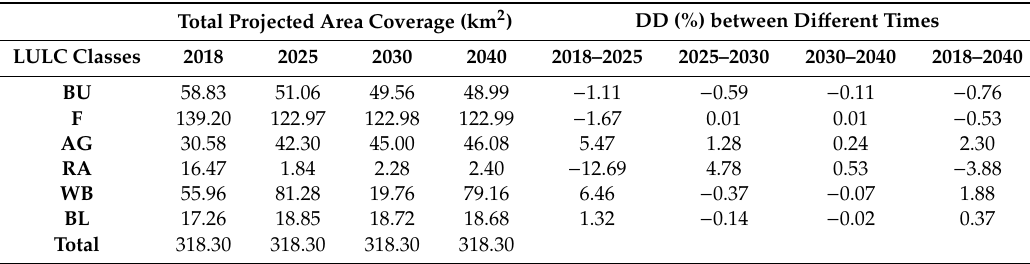
Table 6. Dynamic degree (DD) (%) estimation between di ff erent times based on LULC total area coverage (km 2 ) from 2018 to